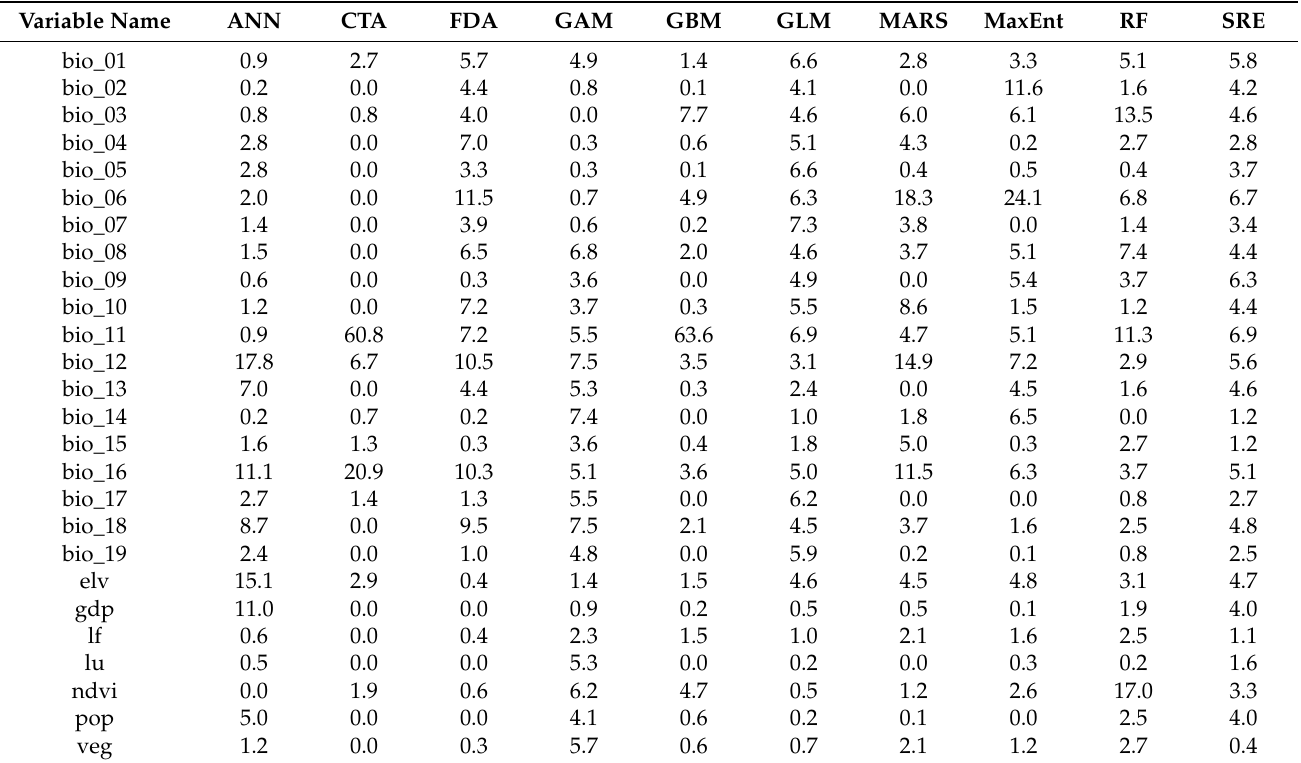
Table 3. Contributions of environmental variables to ten ecological niche models